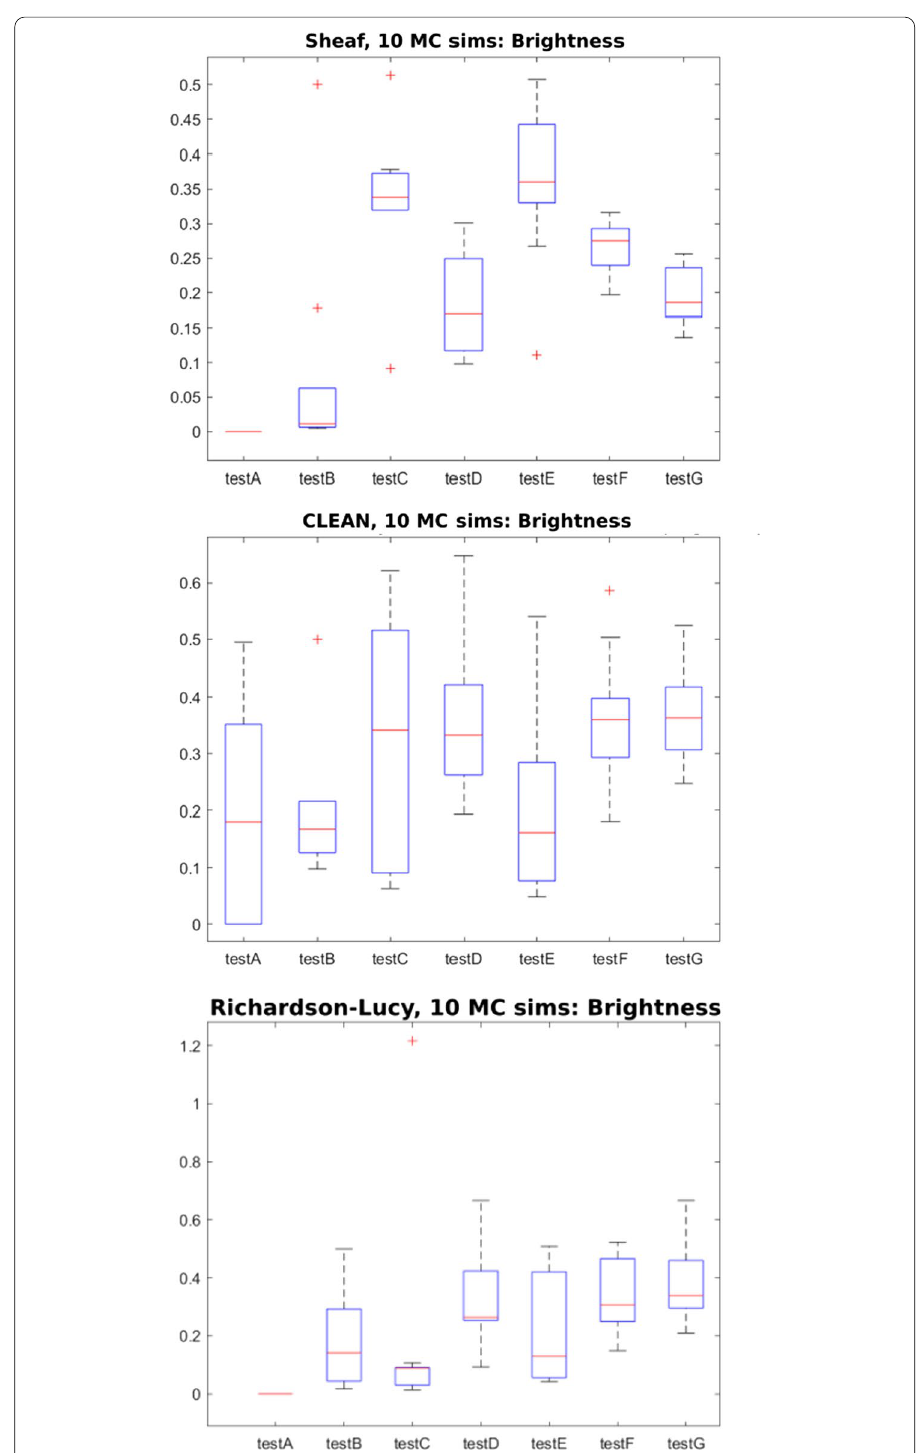
Fig. 11 Magnitude root mean squared error (RMSE) of the sheaf, CLEAN, and Richardson–Lucy algorithms split by Test (see Table 1). The vertical scales differ between frames to emphasize